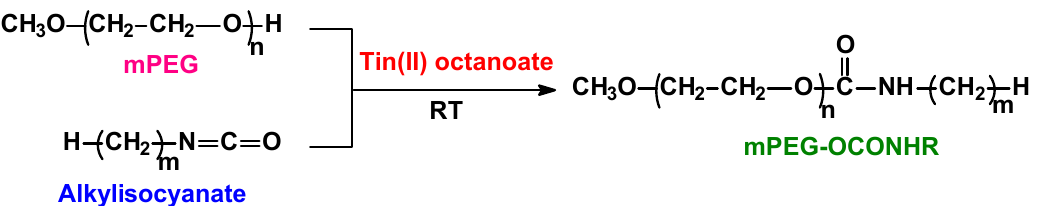
Figure 6. Reaction scheme for the urethane forming reaction of monomethoxypolyethylene glycols (mPEGs) with alkylisocyanates.